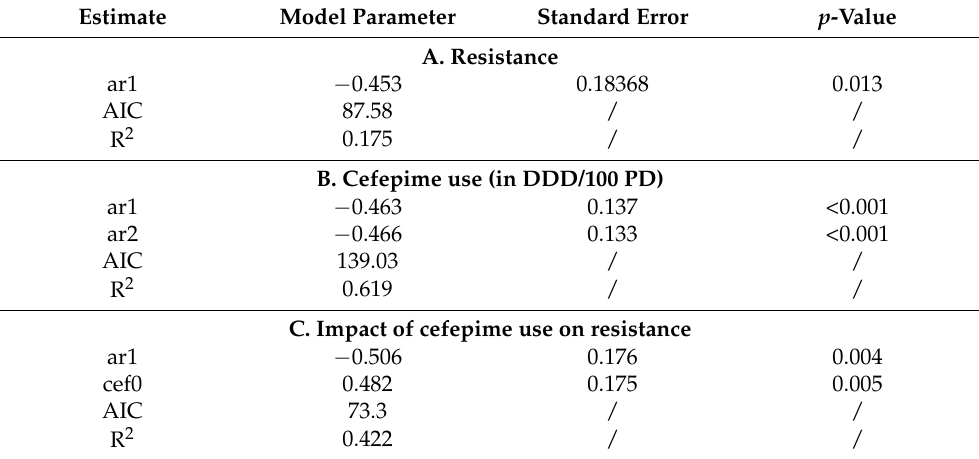
Table 4. ARIMA models for cefepime-resistant P. aeruginosa ( A ) and cefepime use ( B ). Dynamic regression model for the association between cefepime-resistant P. aeruginosa and hospital cefepime use ( C